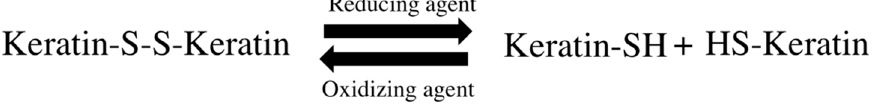
Figure 8. Summarized reaction of hair keratin with treatment of reducing and oxidizing agent